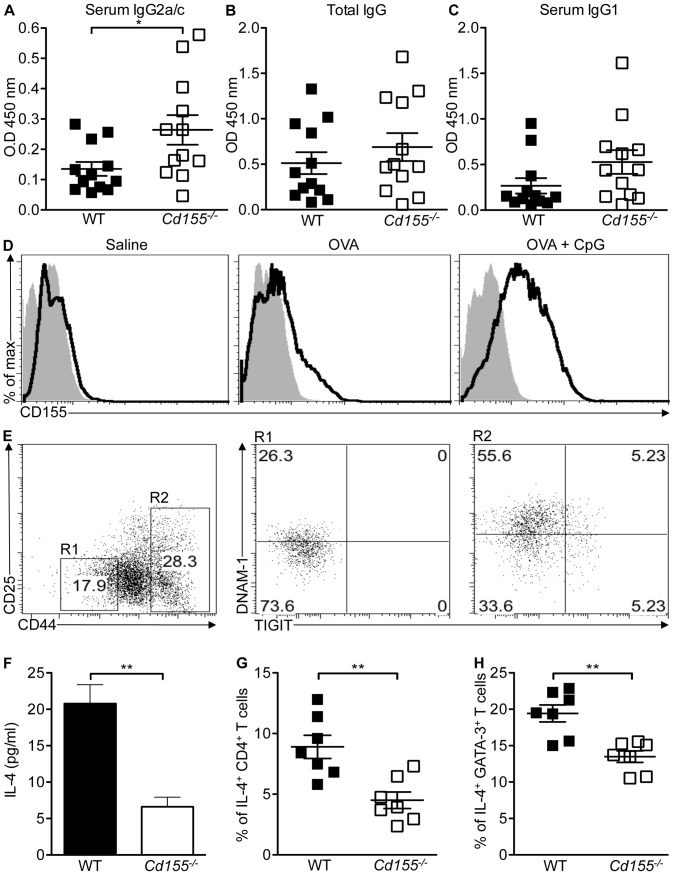
Increase of OVA-specific IgG2a/c antibody titer in Cd155−/− mice immunized with OVA and CpG.(A-D and F-H) Cd155−/− mice (n  = 12) and WT littermate (n  = 12) were immunized i.p. with 20 µg OVA and 50 µg ODN 1668, 20 µg OVA or saline alone. One week later the immunization was repeated. 21 days after first immunization, serum levels of OVA-specific IgG2a/c (A), total IgG (B) and IgG1 (C) antibodies in OVA- and CpG-immunized Cd155−/− mice (open squares) and WT littermates (closed squares) were determined by indirect ELISA at a 1∶100,000 serum dilution. Combined data of three independent experiments are shown. Groups shown in (A-C) were compared using Student’s t-test. Means ± SEM. are indicated, * p<0.05. (D) Splenic B cells (CD19+ cells) of saline, OVA and OVA + CpG ODN 1668-injected WT mice were analyzed for CD155 expression (thick line) by flow cytometry. Filled histogram shows B cells stained with isotype control. (E) Splenocytes of WT mice (n  = 3) were stained for CD3, CD4, CD44, CD25, TIGIT and DNAM-1 expression. Dot blots show TIGIT and DNAM-1 expression in splenocytes electronically gated on CD3+CD4+CD25−CD44low (R1, naïve phenotype, middle panel) or CD3+CD4+CD44high (R2, effector/memory phenotype, right panel) cells. Left panel illustrates CD25 and CD44 gating strategy used for R1 and R2. (F) 5×106 splenocytes of mice injected with OVA and CpG were cultured for 48 hrs, after which the culture supernatant was analyzed for IL-4 levels by ELISA. Data are representative of two independent experiments. (G and H) CD3+CD4+ splenocytes of OVA- and CpG-immunized WT and Cd155−/− mice (n  = 7) were analyzed for intracellular IL-4 (G) and GATA-3 (H) expression by flow cytometry. Data presented in (F-G) were analyzed using Student’s t-test and means ± SEM are shown. ** p<0.01, ns indicates not significant.